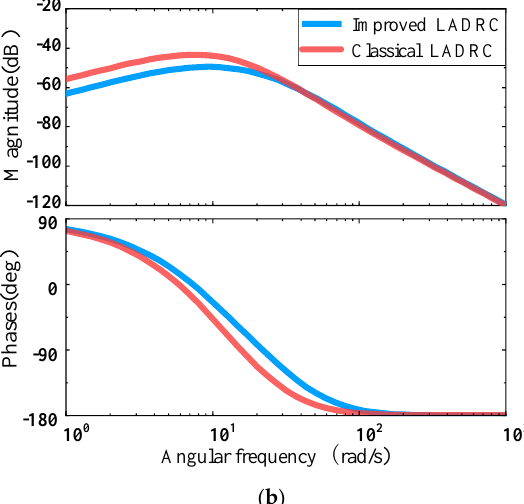
Figure 7. Improved LADRC tracking performance and antidisturbance porter diagram. ( a ) Improved LADRC and classical LADRC tracking performance Bode plot amplitude and frequency characteristics comparison analysis; ( b ) improved LADRC and classical LADRC anti-disturbance performance Bode plot amplitude and frequency characteristics comparison analysis.